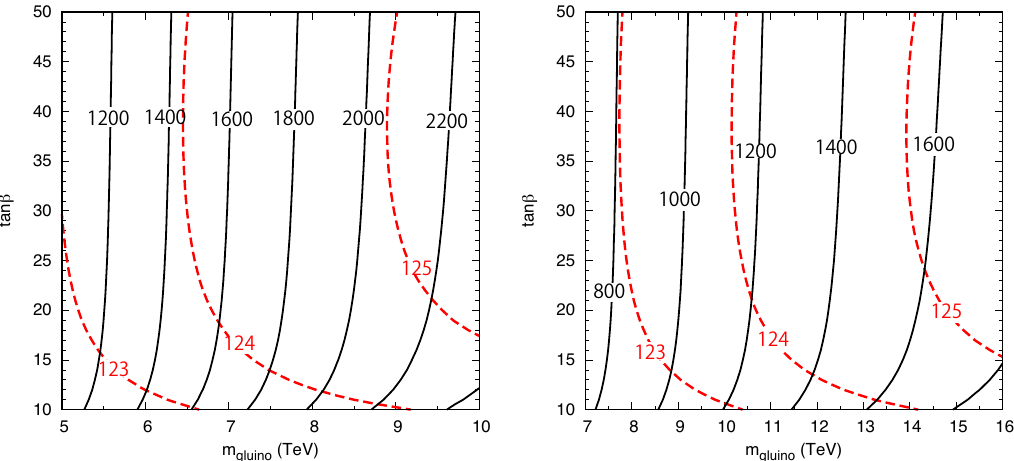
Figure 1 . The contours of (cid:1) (black solid) and m h (red dashed), where m h is shown in units of GeV. We take M mess = 1500 TeV and N 5 = 1 ( M mess = 700 TeV and N 5 = 4) in the left (right) panel. Here, (cid:11) s ( m Z ) = 0 : 1181 and m t (pole) = 173 : 34